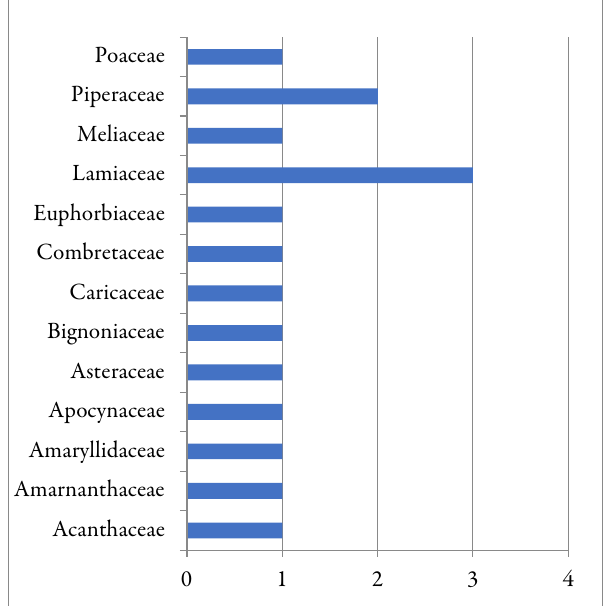
Figure 2. Family distribution of the medicinal plants used by the Monpas of Arunachal Pradesh